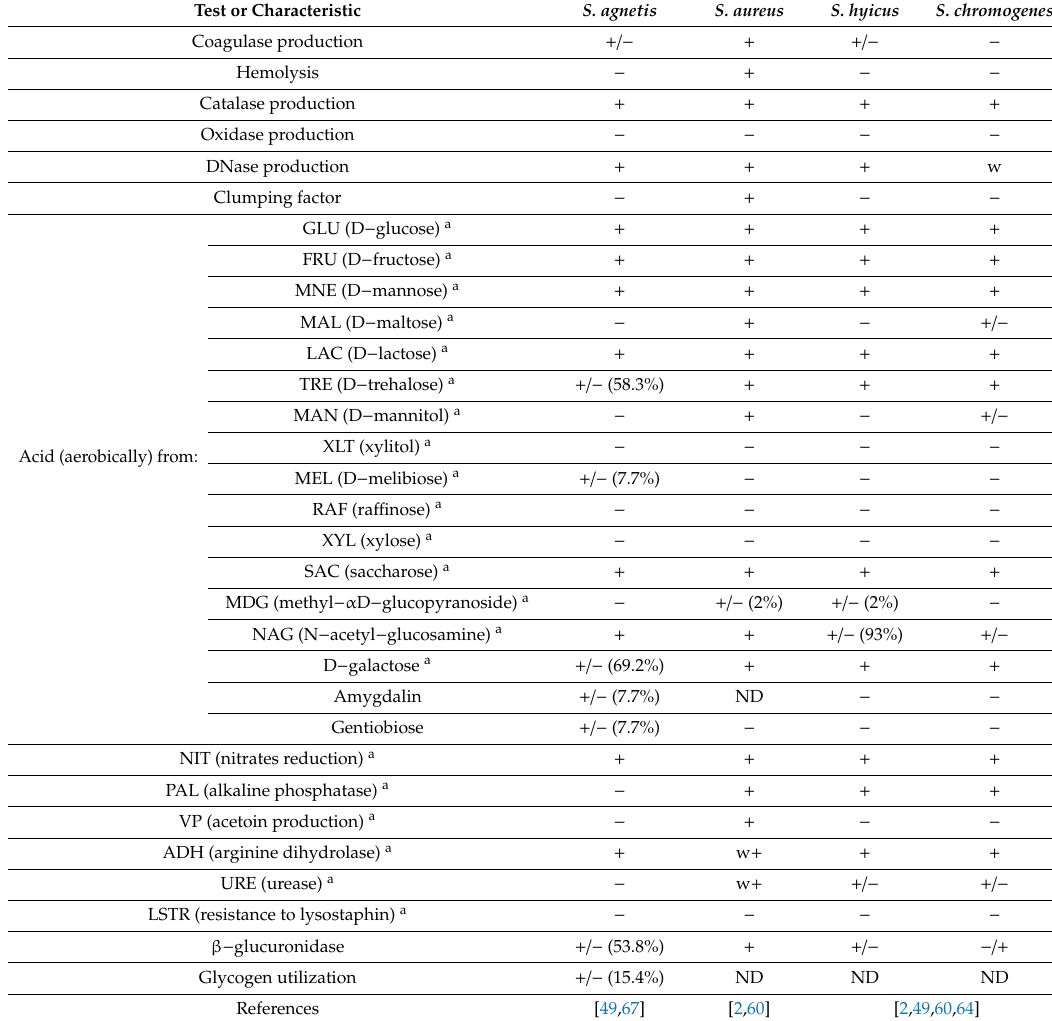
Comparison of selected tests or biochemical characteristics of S. agnetis with other Staphylococcus